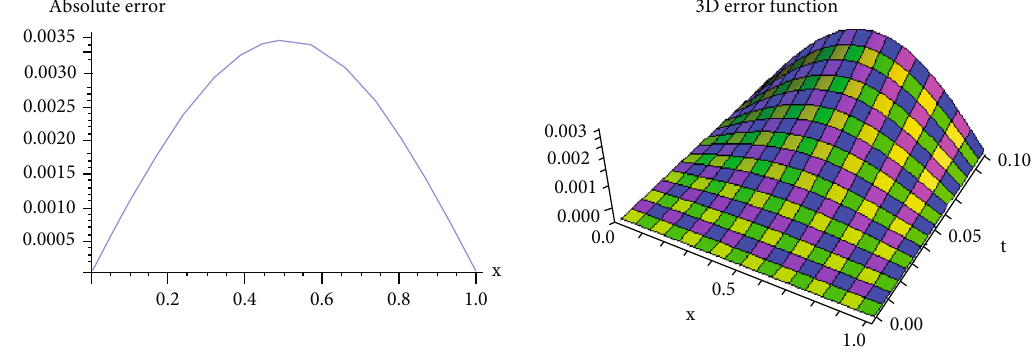
Figure 6: 2D and 3D error pro fi les for Example 6 when h = 1/60, t = 0 : 1, Δ t = 0 : 01